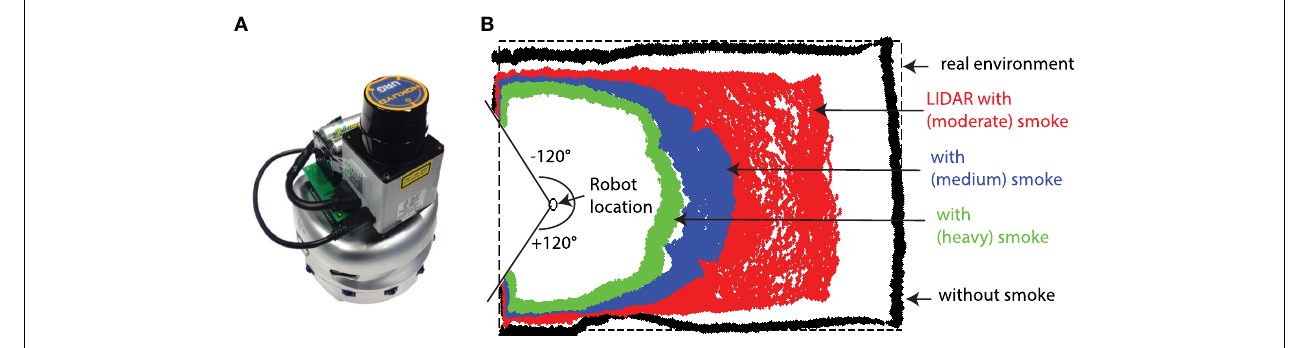
100 scans without and with smoke, respectively. Artificial smoke is produced by a smoke machine (VDL400SM, Velleman). Higher levels of smoke (from moderate to heavy) are obtained by running the machine for longer time periods.